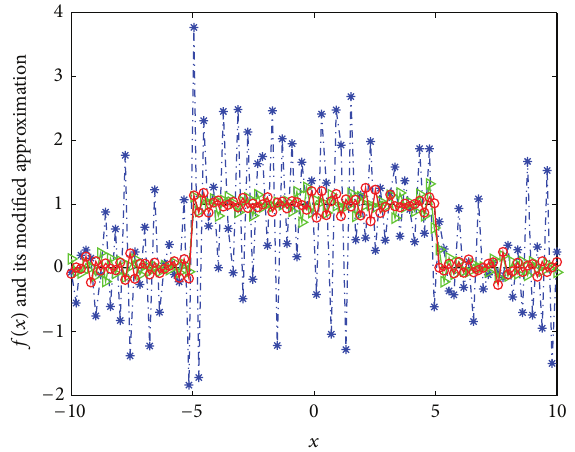
Figure 8: Comparison between the exact solution (- - -) and its computed approximations with 𝑘 = 2 and various noise levels of 𝜀 = 0.01 (−∗−) , 𝜀 = 0.001 (− ⊳ −) , 𝜀 = 0.0001 (− o −) for Example 7.